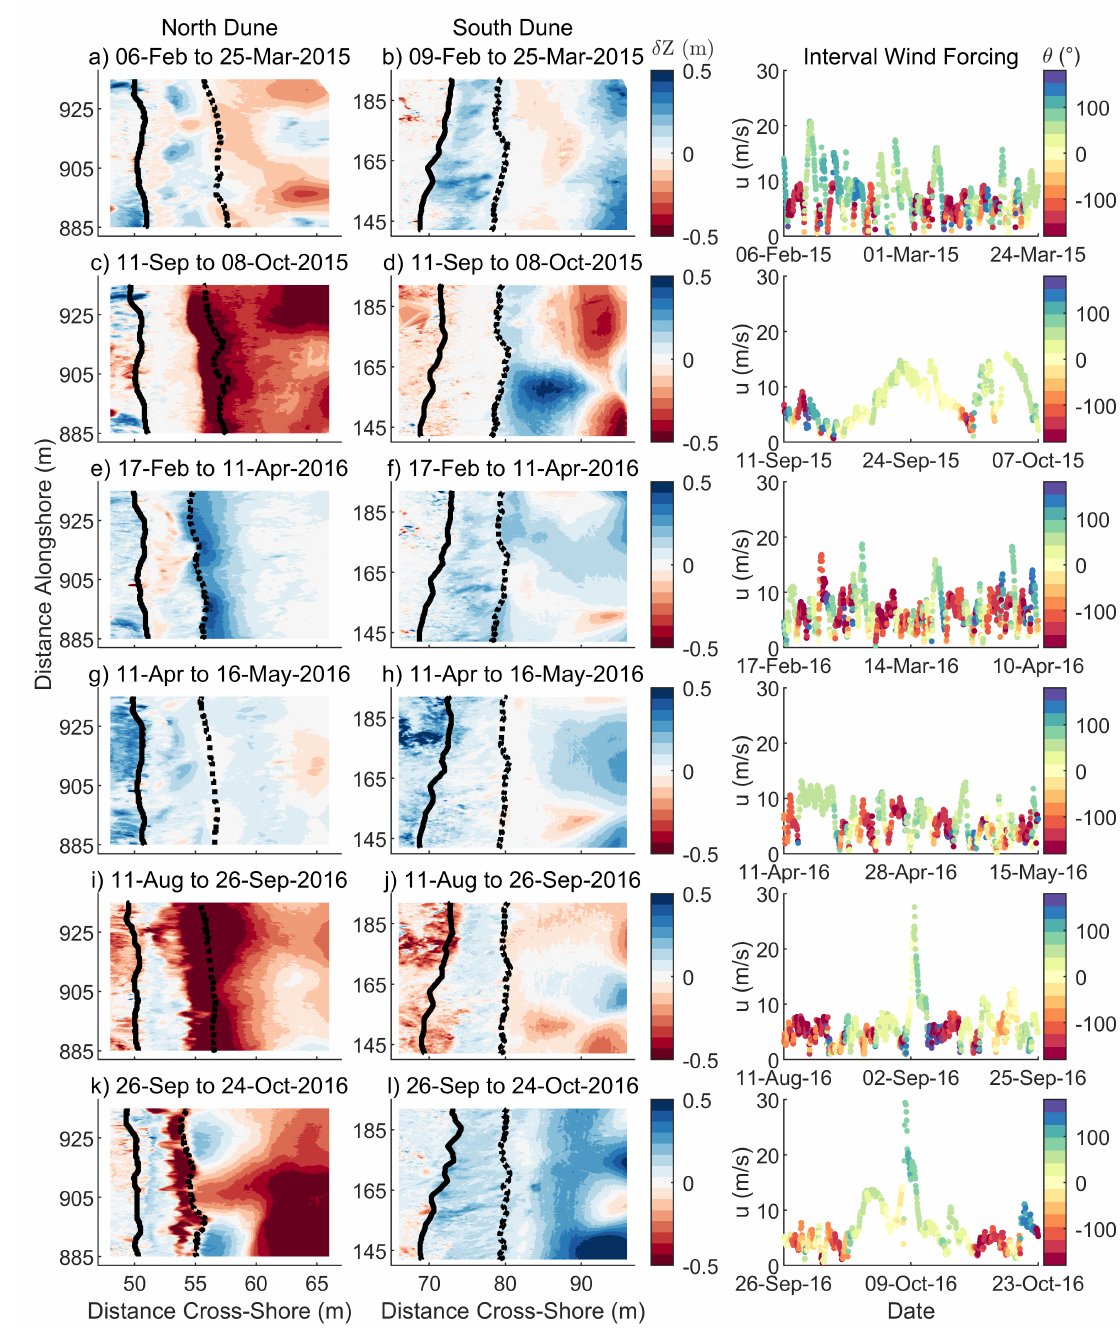
Figure 8. Study site response to storm events. Elevation changes, δ Z , for each spatial grid cell for ( a , b ) winter 2015 Nor’Easters, ( c , d Hurricane Joaquin, ( e , f ) winter 2016 Nor’easters, ( g , h ) spring 2016 Nor’easters, ( i , j ) Hurricane Hermine, ( k , l ) Hurricane Matthew, for the north and south dunes, respectively. The corresponding wind speed, u (y-axis) and direction, θ (colors), for each interval versus time is shown in the far right